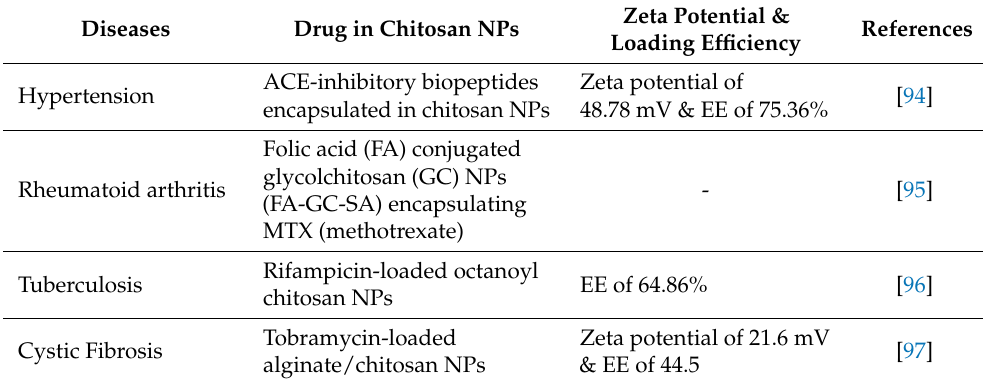
Table 7. Chitosan NPs in miscellaneous